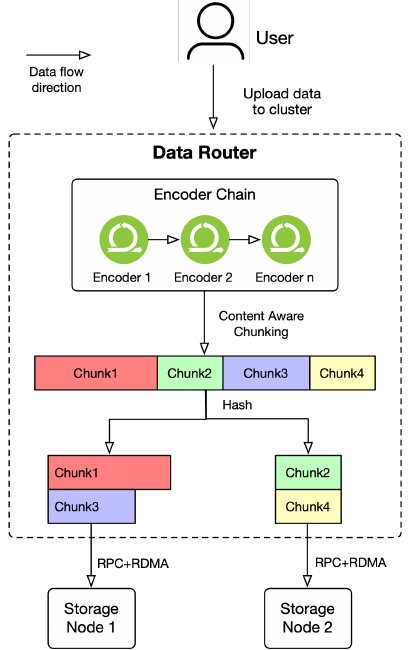
Figure 2. Data flow during the upload